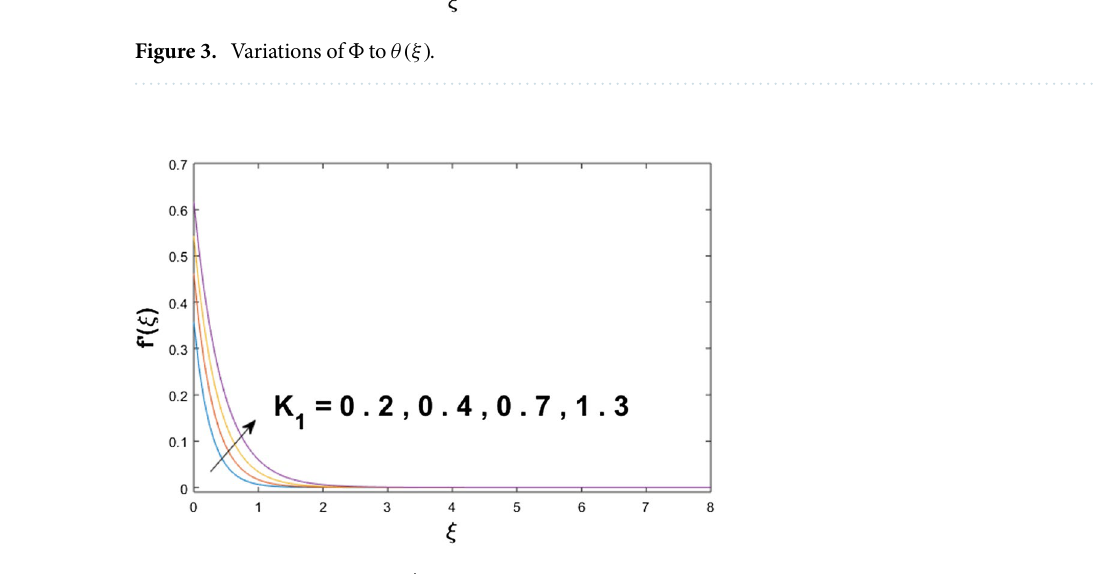
Figure 4. Variations of K 1 to f ′ (ξ) .